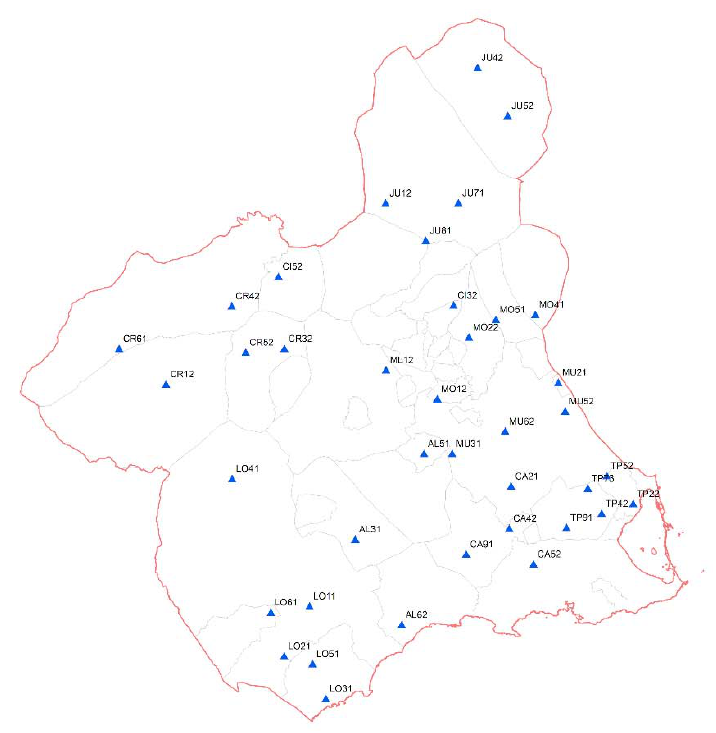
Figure 3. Climatic stations belonging to SIAM placed in diverse locations in the region of Murcia.